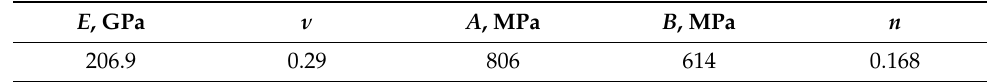
Figure 6. Triangular finite element under uniaxial loading. Table 1. Steel material properties.